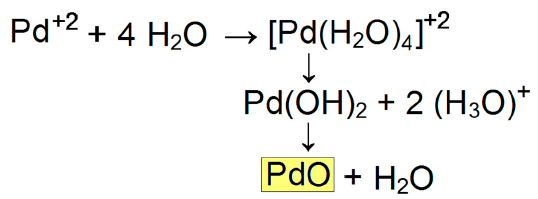
Figure 4. X-ray Photoelectron Spectroscopy (XPS) spectrum in the Pd 3 d region, for colloidal nanoparticles deposited on glass. The predominant peaks, evidenced by light green color, correspond to Pd(II) oxide. Figure 5. Micro-Raman spectra of deposited colloidal nanoparticles. The two spectra, evidenced by different colors, are representative of different points of the sample.